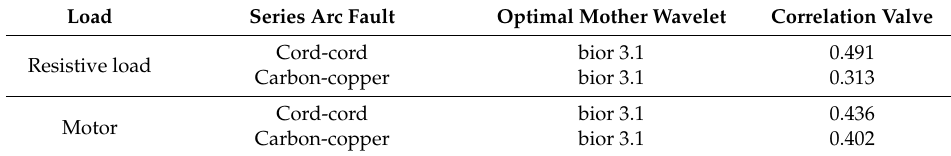
Figure 9. Correlation coefficient calculation. ( a ) arc current pulse in the resistive load with a cord-cord fault; ( b ) result of optimal mother wavelet selection. Table 1. Results of optimal mother wavelet selection.